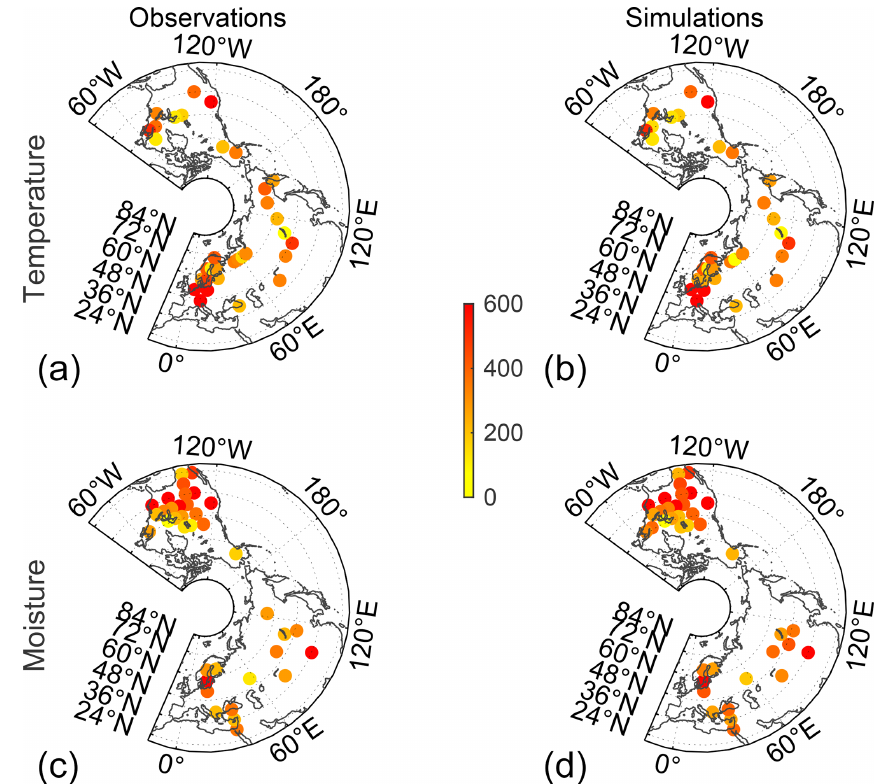
Figure 3. Numbers of years (color scale) available for comparison between gridded, observed and climate-sensor-simulated TRW chronolo- gies, within the period 1401–2000. (a, c) Observed and (b, d) simulated temperature-sensitive chronologies. Simulated chronologies are masked by observational availability and in some cases (e.g., subpolar Eurasia) are neither moisture- nor temperature-sensitive or are both temperature and moisture sensitive and thus do not appear in either simulation map. Panels (c) and (d) are the same as panels (a) and (b) but for moisture-sensitive chronologies. (Maps created with MATLAB mapping package M_map; Pawlowicz,